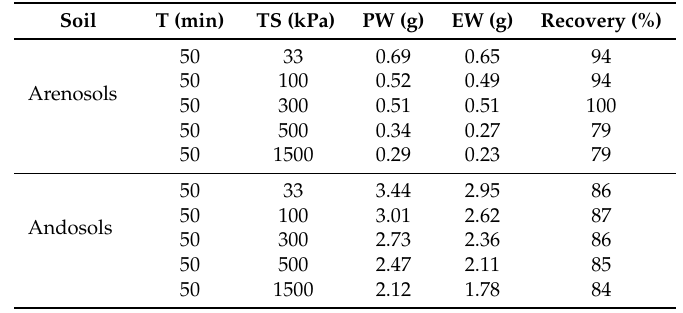
Table 4. Summary of results for experiment B, including time of extraction (T), water tension of the soil sample TS, pore water before extraction, PW, extracted water EW, and percentage of recovery as the ratio PW to EW.